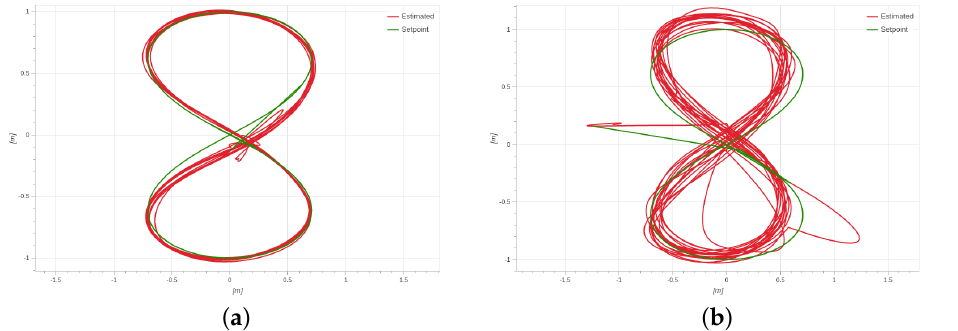
Figure 9. Drone trajectory captured by the visual motion capture system OptiTrack in the horizontal plane. ( a ) Rigid-frame drone QAV-R 5 (cid:48)(cid:48) Racer. ( b ) Second-generation tensegrity drone.